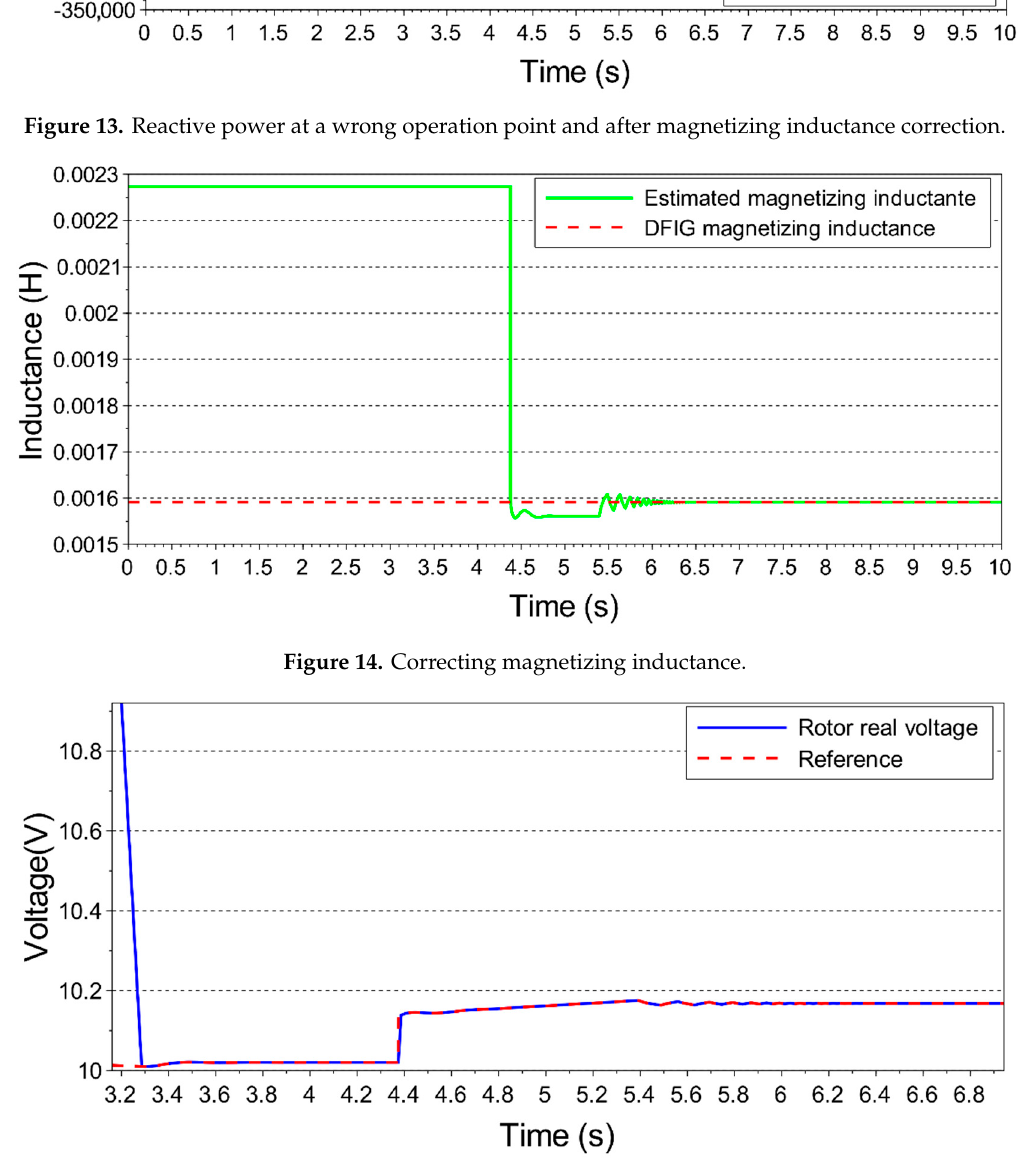
Figure 16. (cid:1848) (cid:3019)(cid:3036) reference update. In order to test the proposed control in situations near to real conditions, a set of real measurement data of wind speed in a real farm was obtained. A selected range of 10 min, characterized by the mean value and standard deviation, was used to compose 600 points following a normal distribution. This variation is presented in Figure 17. Figure 17. Wind variation in time.